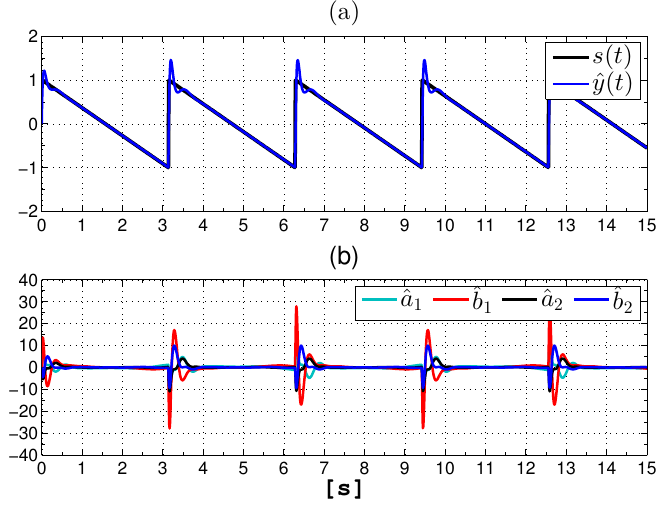
Figure 4. Example 2. ( a ) Triangular wave reconstruction and ( b ) Estimated